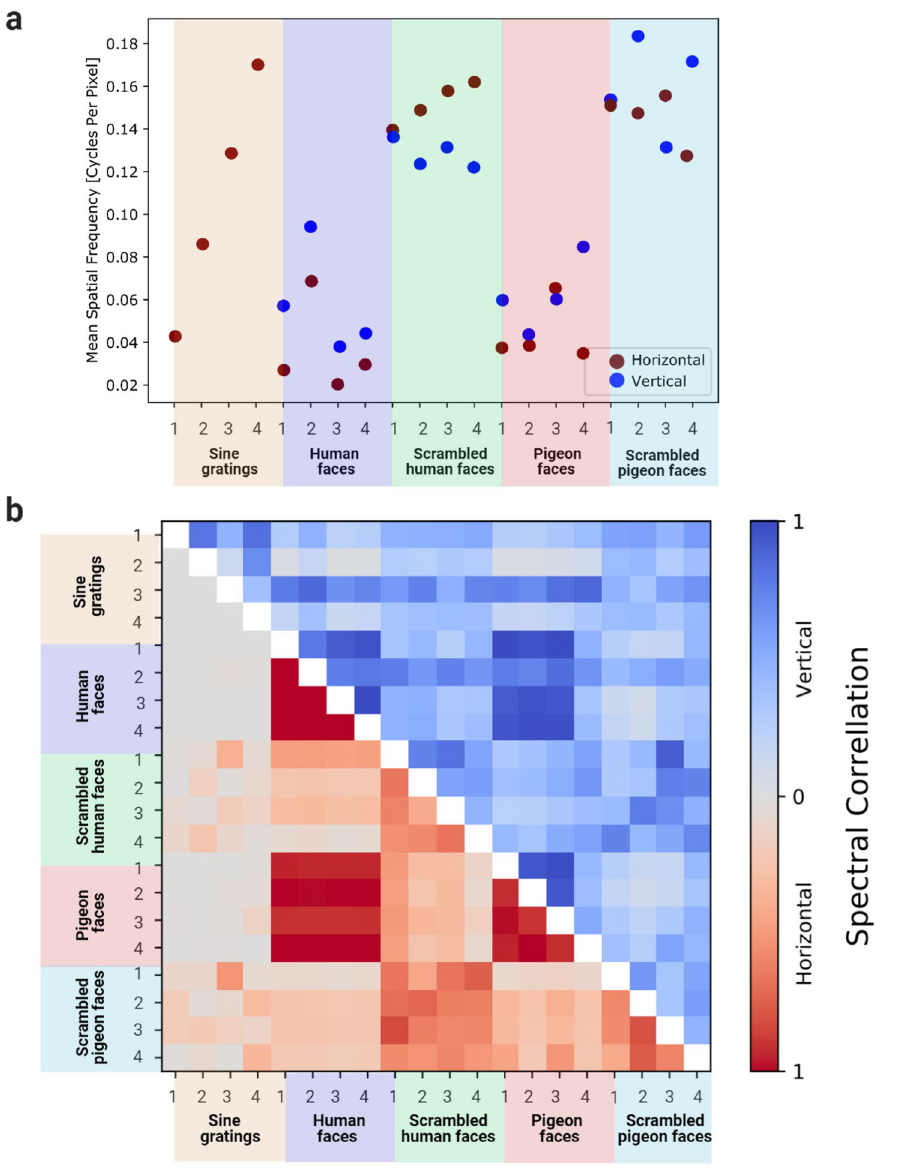
Figure 6. Spectral analysis of the image set. ( a ) The energy-weighted spectral average for a cross-section of each image in the horizontal and vertical directions, with the zero-frequency component omitted. The spatial frequencies of the scrambled images are centred much higher than for the unscrambled images, a result likely due to the high frequencies generated by the harmonics of the sudden transitions at the edges of the scrambled segments, and the interruption of low-frequency spatial information by the scrambling process. Vertical spatial frequency values for sine gratings are omitted for clarity as they only exist as an image compression artefact. ( b ) The energy-normalised spectral correlations between images, by a cross-section in the horizontal (upper triangle, red), and vertical (lower triangle, blue)